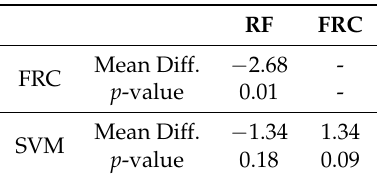
Table 12. Dunn test for the fine-grained classifiers.